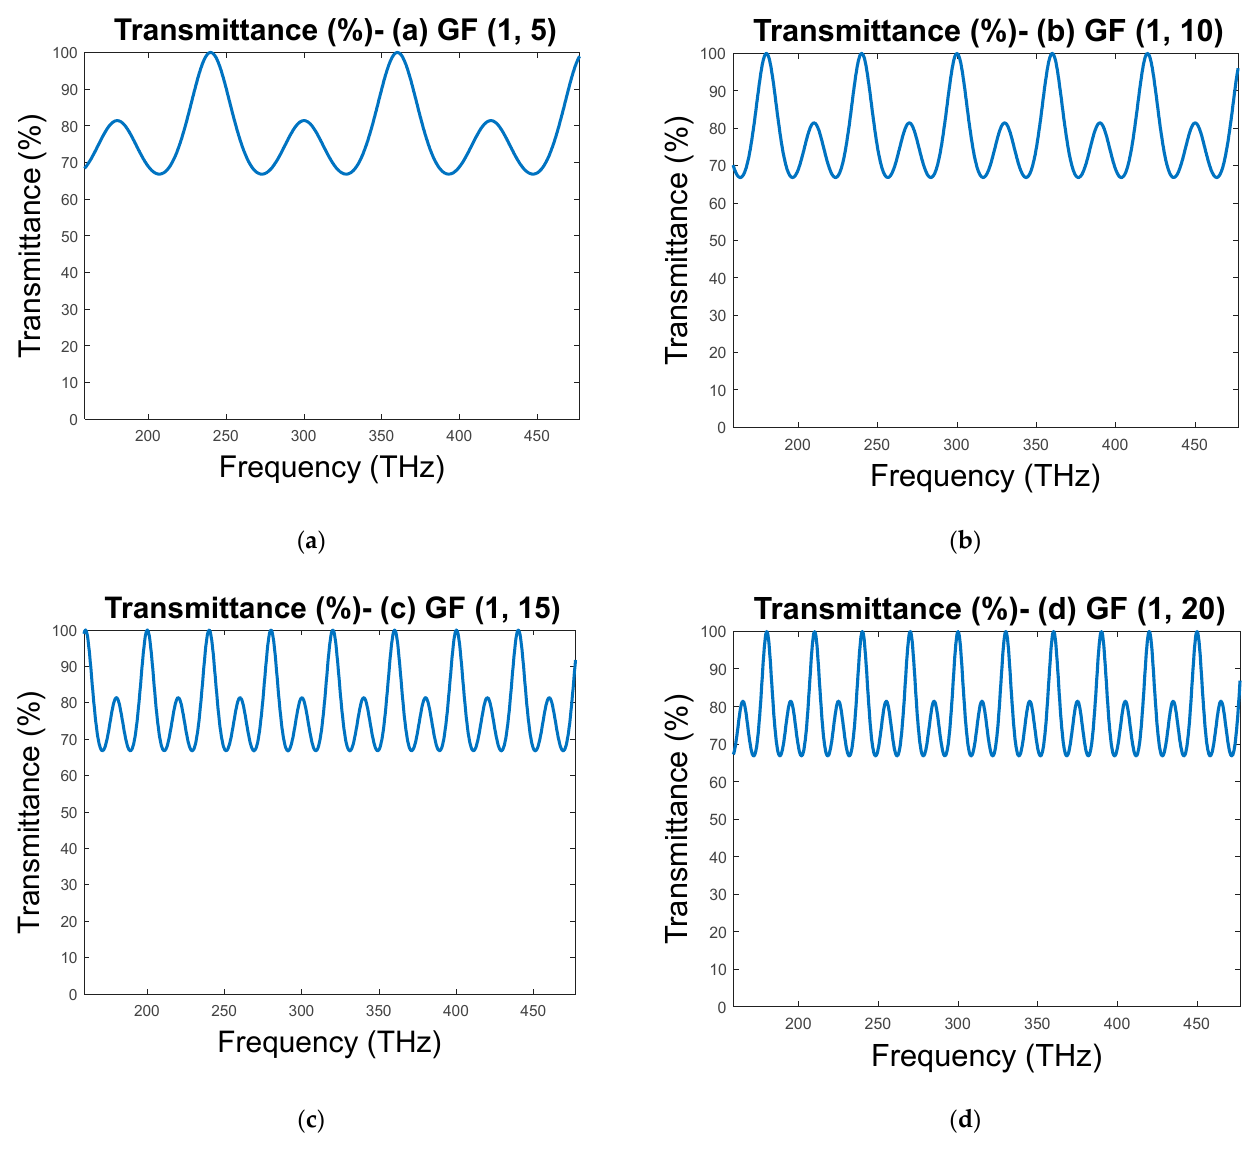
Figure 5. Transmittance spectra versus frequency for 1D GF sequence (3 rd iteration) and for ( a ) GF (1, 5), ( b ) GF (1, 10), ( c ) GF (1, 15), and ( d ) GF (1, 20).